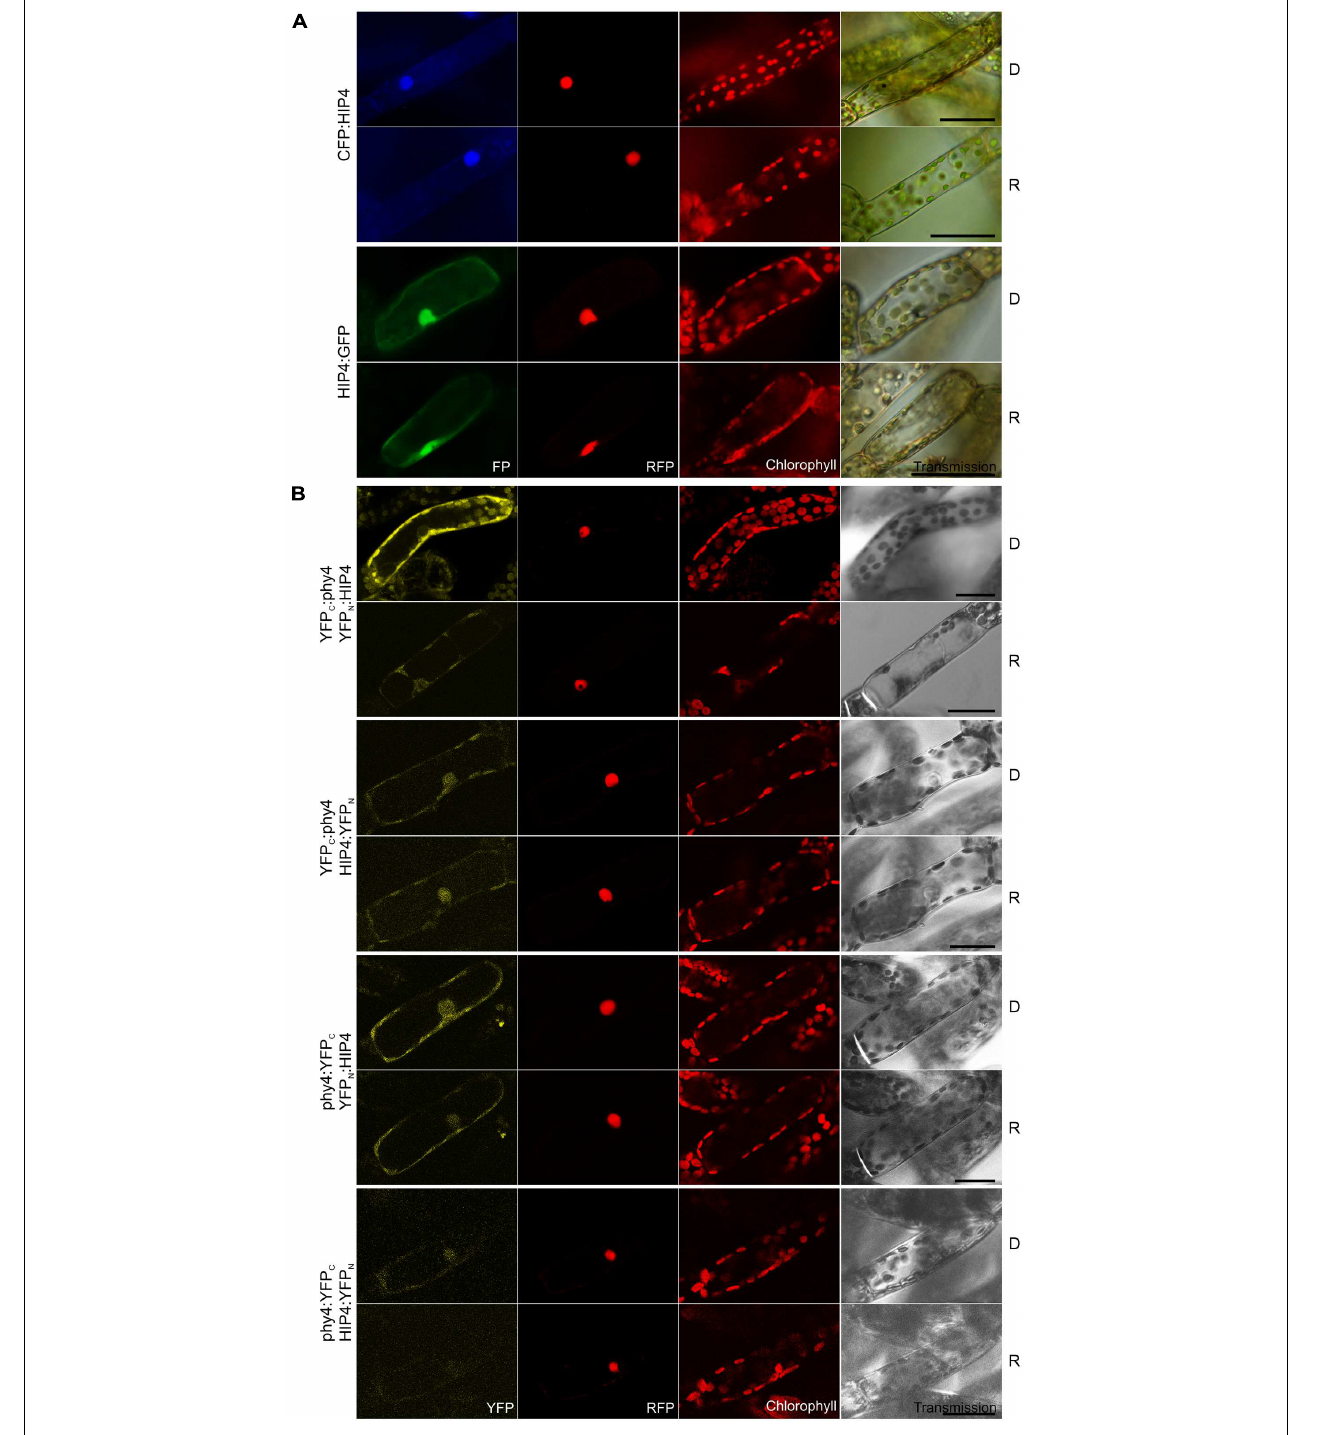
FIGURE 3 | HIP4 (Pp3c16_8560E1.1) intracellular localization (A) and split-YFP-studies of HIP4–phy4 interaction (B) each without (D) and with red pre-treatment (R) using fluorescence- and confocal microscopy, respectively. Overall figure structure is analogous to Figure 1 . (A) CFP:HIP4 (rows 1 and 2) was mostly nuclear and HIP4:GFP (rows 3 and 4) was distributed in nucleus and cytoplasm (column 1, FP). (B) All possible split-YFP configurations were analyzed in D and R, respectively: YFP C :phy4–YFP N :HIP4 (rows 1 and 2), YFP C :phy4–HIP4:YFP N (rows 3 and 4), phy4:YFP C –YFP N :HIP4 (rows 5 and 6) and phy4:YFP C –HIP4:YFP N (rows 7 and 8). Significant signals were observed for YFP C :phy4–YFP N :HIP4 (cytoplasmic signal), phy4:YFP C –YFP N :HIP4 (nucleo-cytoplasmic signal), and weakly for YFP C :phy4–HIP4:YFP N (maybe nucleo-cytoplasmic signal) in both D and R (column 1, YFP). phy4:YFP C –HIP4:YFP N yielded only background signals alongside channel bleed-through. Scale bars 30 µ